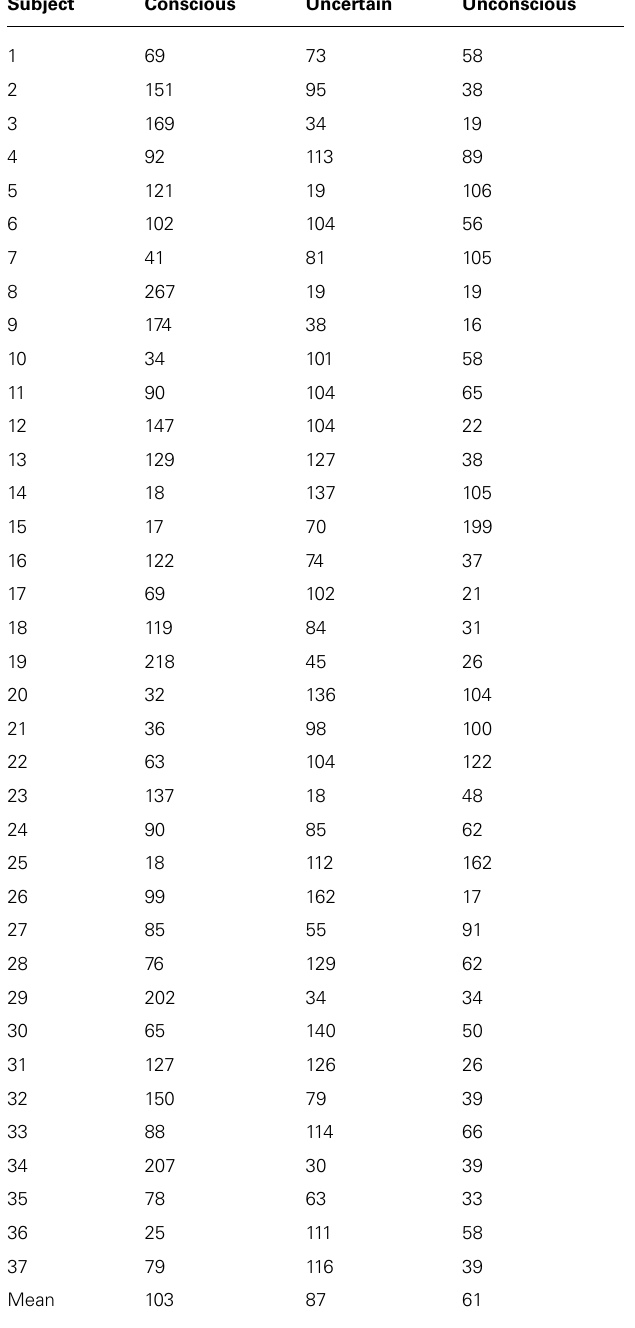
Table 1 | Number of included trials in each condition (conscious, uncertain, or unconscious) per subject and the overall